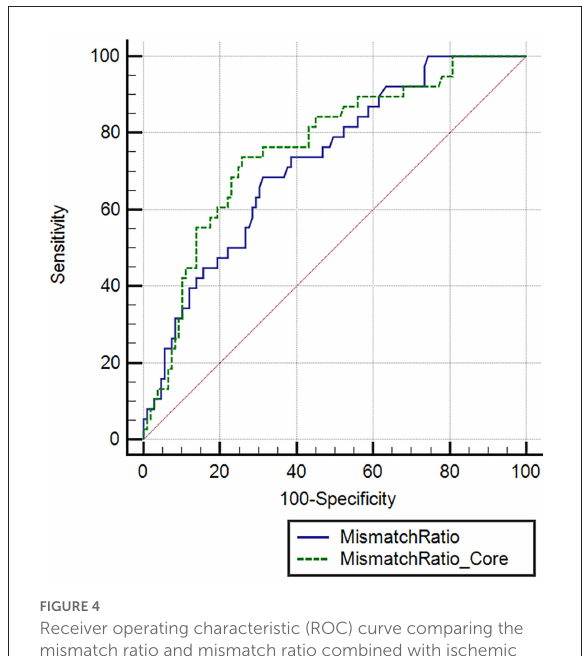
FIGURE4 Receiver operating characteristic (ROC) curve comparing the mismatch ratio and mismatch ratio combined with ischemic core to predict RPBE. Mismatch ratio, area under the curve (AUC): 0.727 (95% CI 0.647–0.796, P < 0.001). Mismatch ratio combined with ischemic core, AUC: 0.763 (95% CI 0.686–0.829, P <